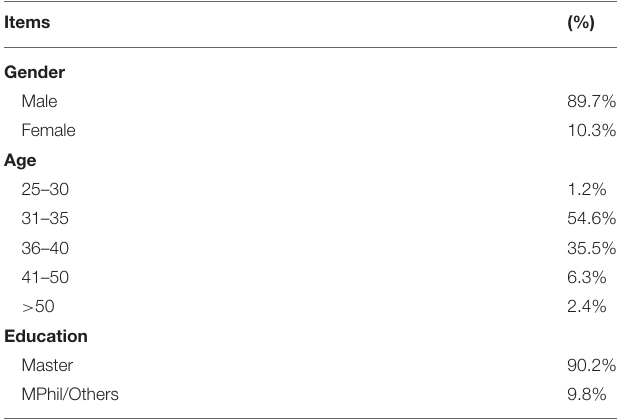
TABLE 1 | Demographic